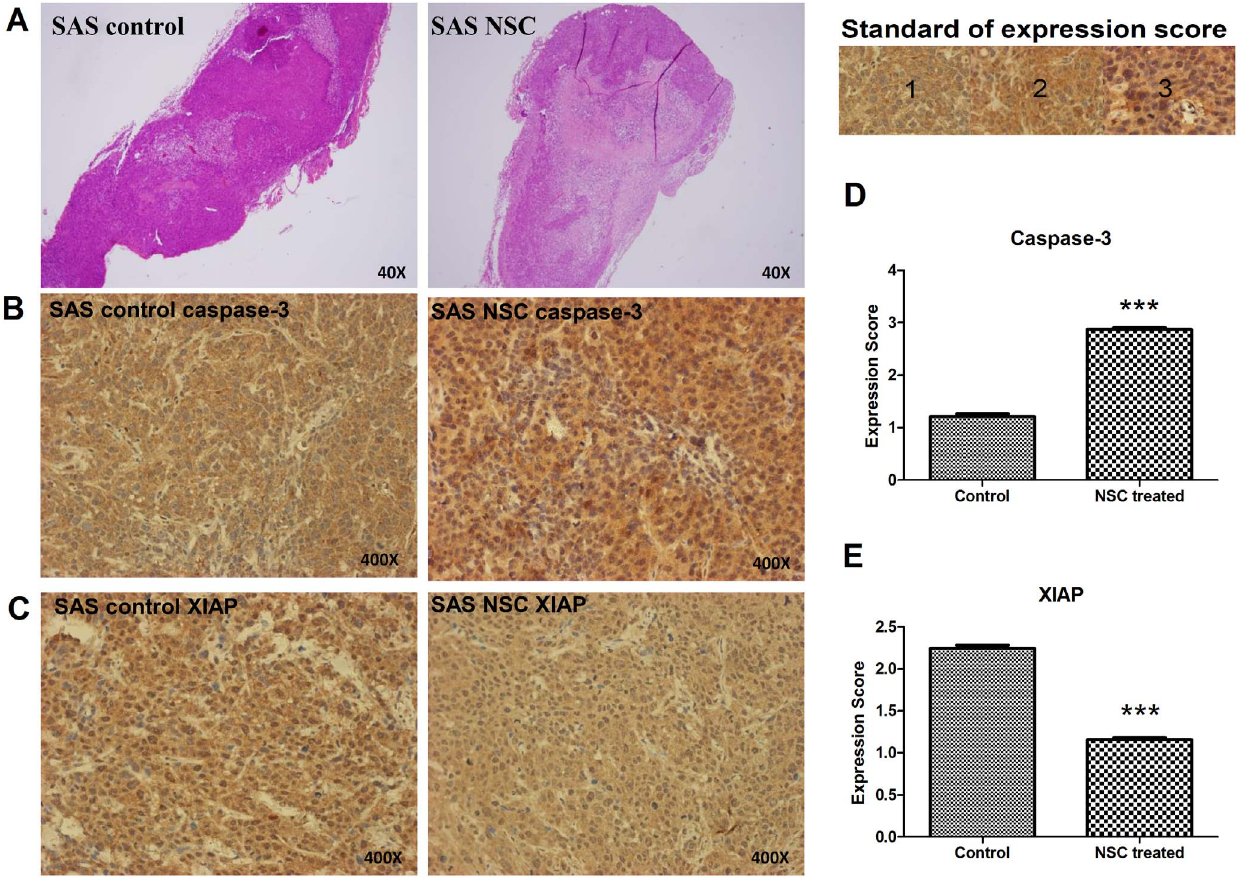
Figure 7. NSC745885 treatment induced apoptosis in xenografted tumors. (A) The histological changes in tumor grafts were assessed using HE staining. Comparing the PBS control with the NSC745885-treated groups revealed a marked tumor necrosis in the NSC745885-treated group. (B) The expression level of caspase-3 in the isolated tumor grafts were evaluated using immunohistochemical staining. (C) The expression level of XIAP in isolated tumor grafts were also evaluated using immuno-histochemical staining. The expression scores for caspase-3 (D) and XIAP (E) were quantified, revealing an increase in the expression of caspase-3 with NSC745885 treatment (P , 0.05). By contrast, the expression of XIAP in tumor grafts decreased with this treatment (P ,